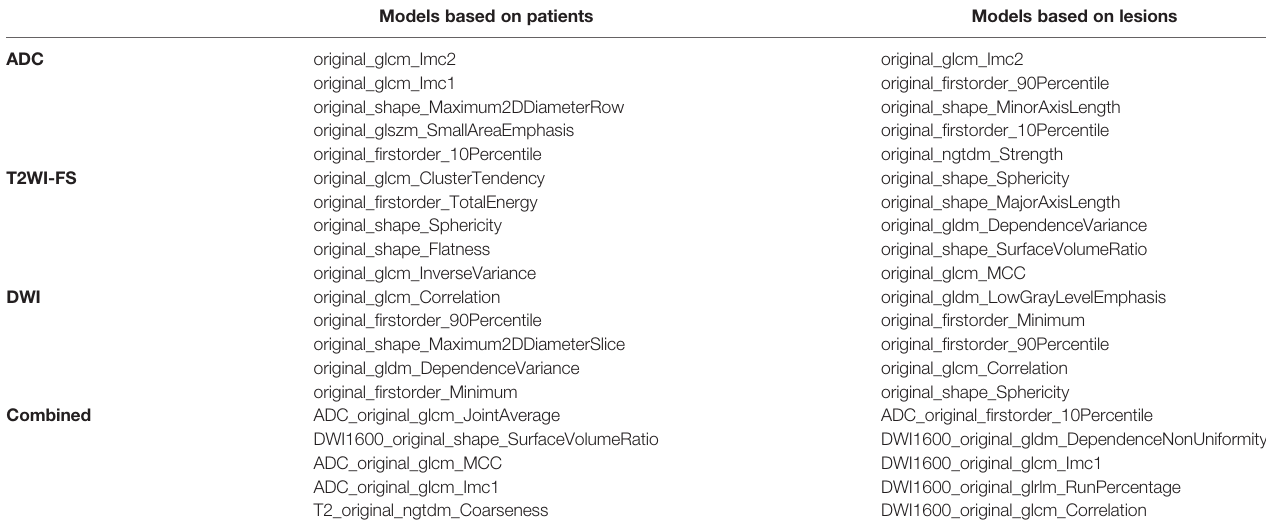
TABLE 2 | Top fi ve most important parameters in each model. Models based on patients Models based on lesions